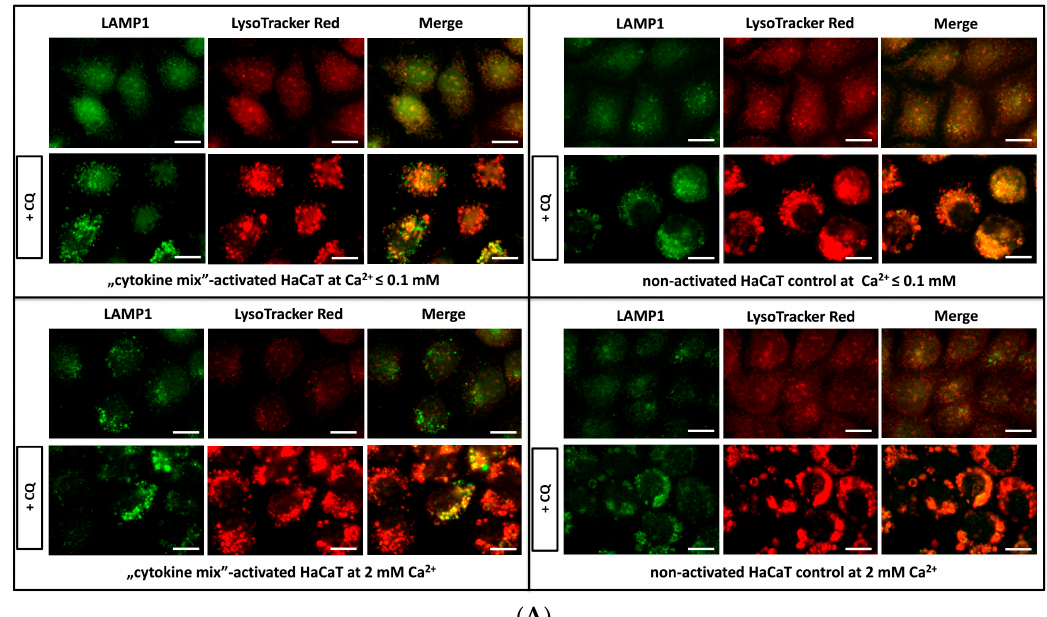
Figure 1. Fluorescence microscopy analysis of lysosomal compartments and other acidic vesicles in keratinocytes. Shown are representative microscopy images of HaCaT cells: (i) Activated with “cytokine mix”: interleukin 1 alpha (IL-1 α ), IL-17A, IL-22, oncostatin M (OSM), and tumor necrosis factor alpha (TNF- α ) at a concentration of 2 ng / mL each constituent and cultured in medium containing Ca 2 + ≤ 0.1 mM; (ii) non-activated HaCaT cell control cultured in medium containing Ca 2 + ≤ 0.1 mM; (iii) “cytokine mix”-activated HaCaT cells cultured in medium containing 2 mM Ca 2 + ; and (iv) non-activated HaCaT cell control cultured in medium containing 2 mM Ca 2 + . Control with chloroquine (CQ) was used to increase the total amount of lysosomes. All images were captured from randomly selected ten microscopic fields containing 50–100 cells, each from three independent experiments ( n = 3), using a fluorescence microscope. Scale bar represents 0.25 µ m. ( A ) LysoTracker Red DND-99 staining showing the distribution of acidic organelles, including mature lysosomes and lysosomal-associated membrane protein 1 (LAMP1) staining of the lysosomal membrane.